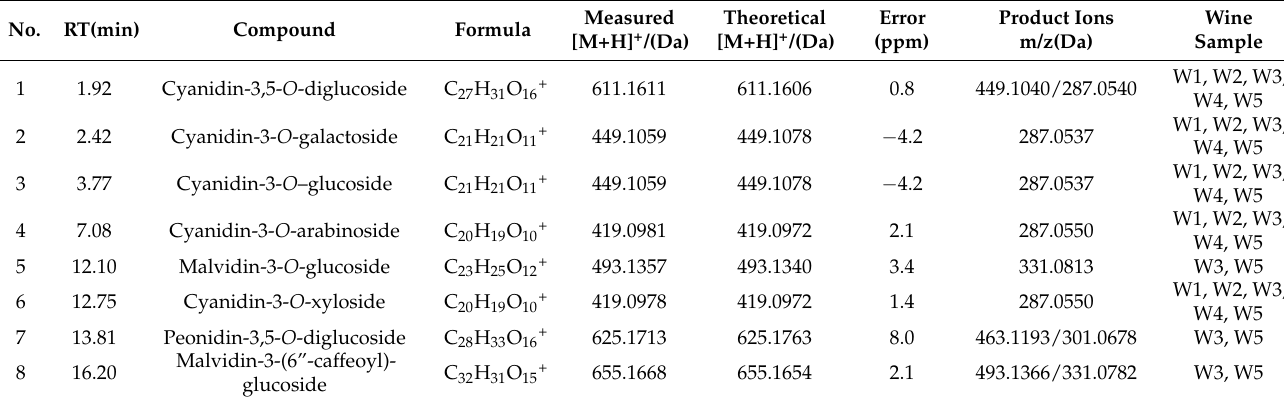
Table 2. Characterization of anthocyanins in black chokeberry